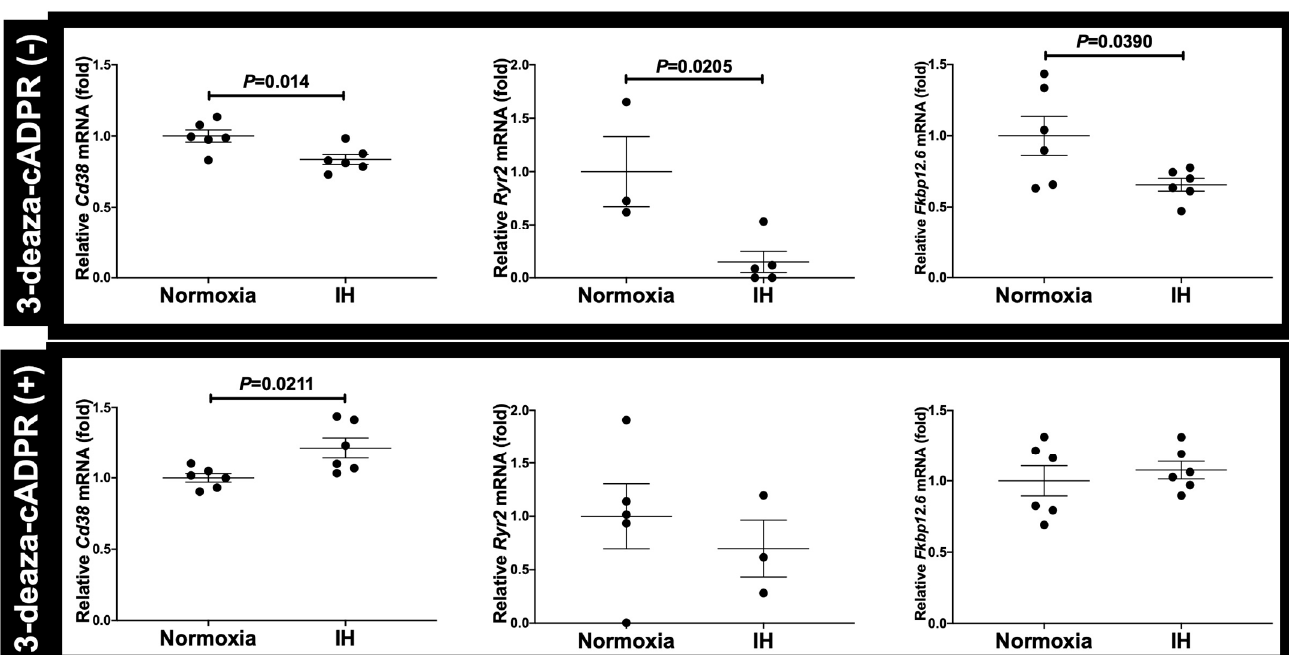
Figure 8. The mRNA levels of Cd38 , Ryr2 , and Fkbp12.6 in the presence or absence of 3 ‐ deaza ‐ cADPR. No differences in Ryr2 and Fkbp12.6 mRNA levels were observed under normoxia and under IH in the presence of 3 ‐ deaza ‐ cADPR (0.6979 ‐ fold decrease in 3 ‐ deaza ‐ cADPR (+) ( p = 0.5260) and 1.076 ‐ fold increase in 3 ‐ deaza ‐ cADPR (+) ( p = 0.5501), respectively). By contrast, the Cd38 mRNA level under IH increased by 1.214 ‐ fold relative to that under normoxia in the presence of 3 ‐ deaza ‐ cADPR ( p = 0.0211). Although the mRNA levels of Cd38 , Ryr2 , and Fkbp12.6 decreased in response to IH in the absence of 3 ‐ deaza ‐ cADPR (3 ‐ deaza ‐ cADPR ( − ) controls), this trend was not observed following the addition of the 3 ‐ deaza ‐ cADPR (3 ‐ deaza ‐ cADPR (+)). The mRNA level exposed to normoxia was set to 1.0. Data are expressed as the mean ± SE of six independent experiments ( n = 6). Student’s t ‐ test was employed in statistical analyses.